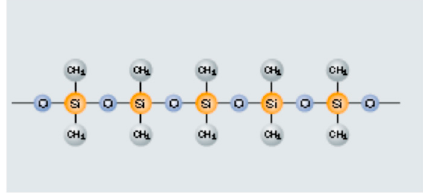
Figure 7. Linear silicone polymer (polydimethylsiloxane).